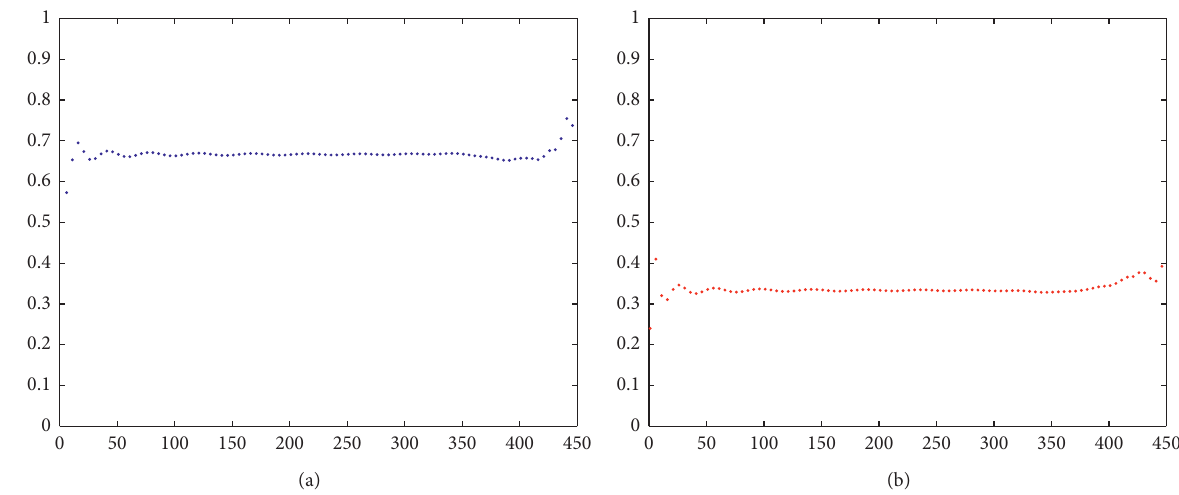
Figure 1: The stable behavior of the prey and predator populations for Example 1 to the equilibrium population points. (a) The graph on p 1 − t plane of Example 1. (b) The graph on p 2 − t plane of Example 1.